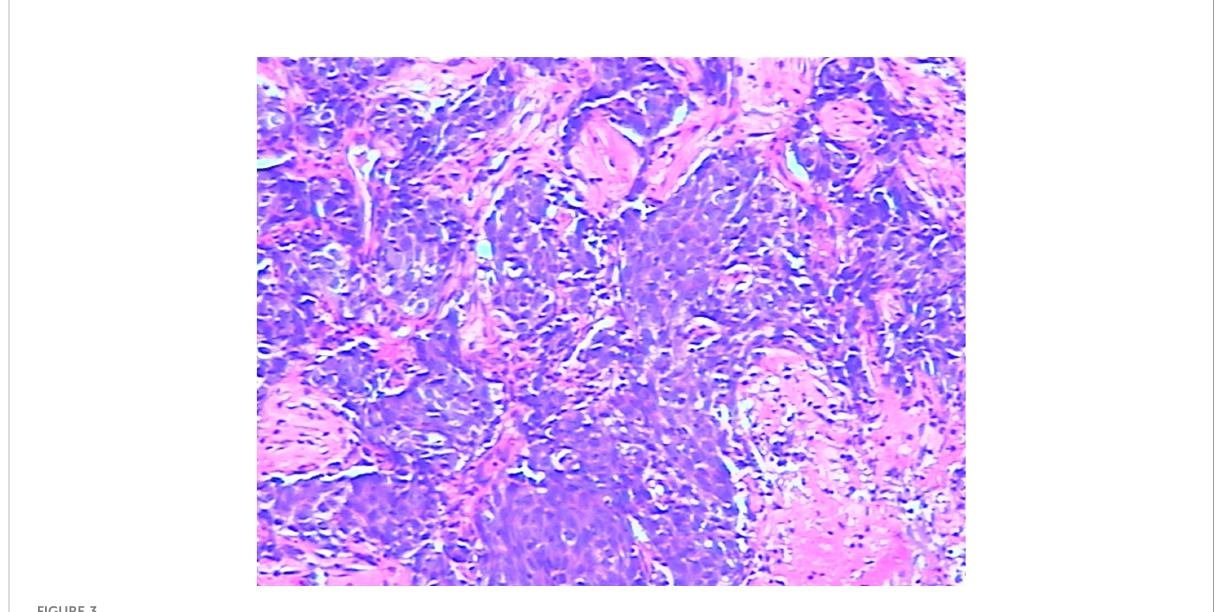
FIGURE 3 Puncture pathology of the left porta of the lung.